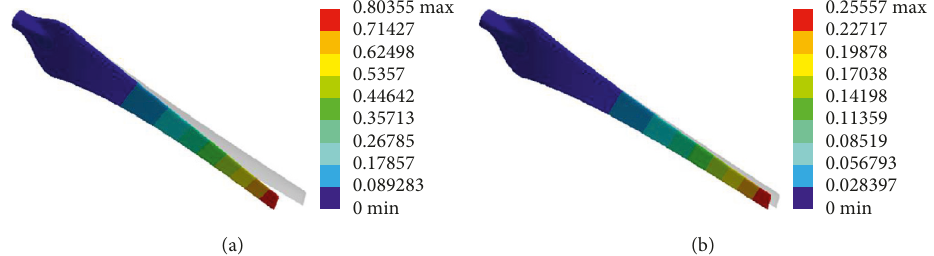
Figure 13: Total deformation for E-glass-epoxy and basalt-epoxy at 40m/s.